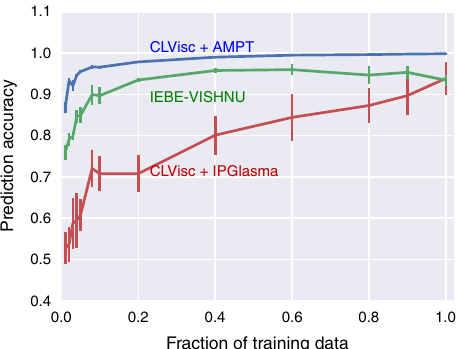
Fig. 4 The dependence of testing accuracies on training data size. The prediction accuracy on testing data when different fractions of the training data is used to train the network. The solid lines and error bars represent the mean and the standard deviation of prediction accuracies from trained models in 10-fold cross